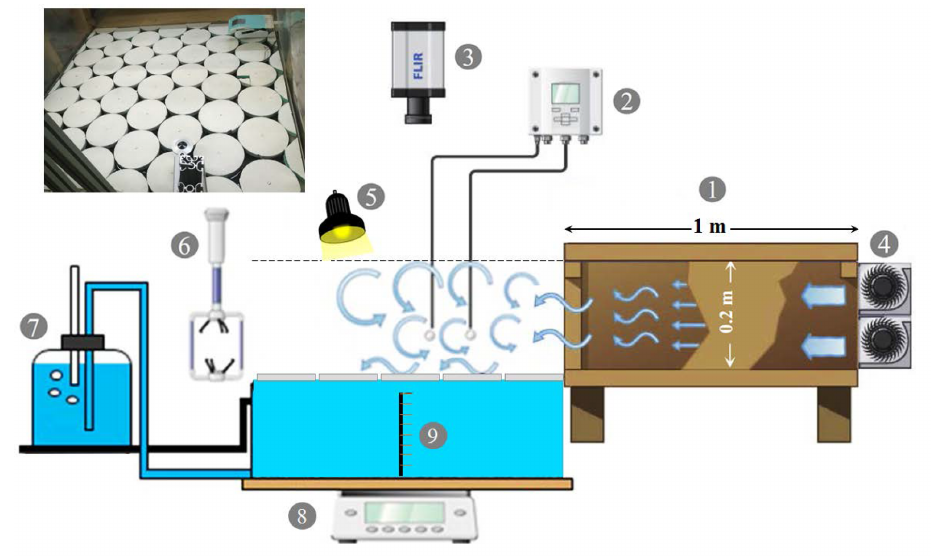
Figure 4. Experimental setup for evaporation suppression measurements from a small water basin covered with floating discs: (1) wind tunnel, (2) air temperature and humidity sensors (Vaisala HUMICAP, HMT337, Finland), (3) IR camera (FLIR SC6000, USA), (4) tunable fans generating wind flow, (5) xenon lamps for shortwave radiation, (6) high-frequency 3-D sonic anemometer (WindMaster, Gill Instruments Ltd., the Netherlands), (7) Mariotte bottle to adjust water level, (8) balance to determine mass loss and evaporation rates, (9) temperature sensors in water body. Table 1. The physical properties of water and the Styrofoam discs (white and black surfaces) used for modeling. Specific heat Emissivity Albedo Thermal